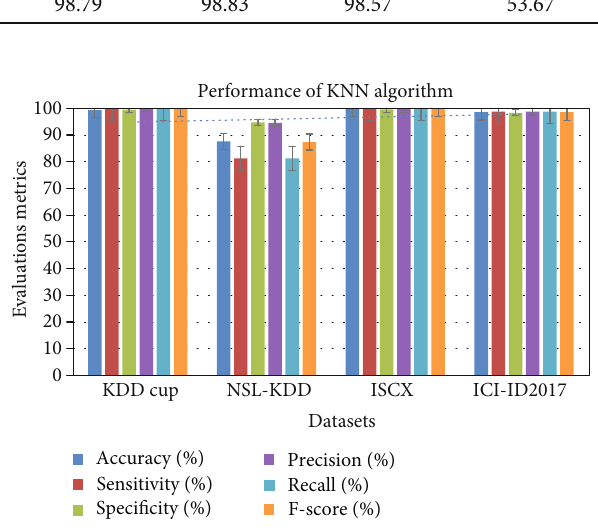
Figure 7: Performance of KNN algorithm of testing results to classify anomaly based on cyberattacks. Table 10: Confusion matrix of LSTM-RNN